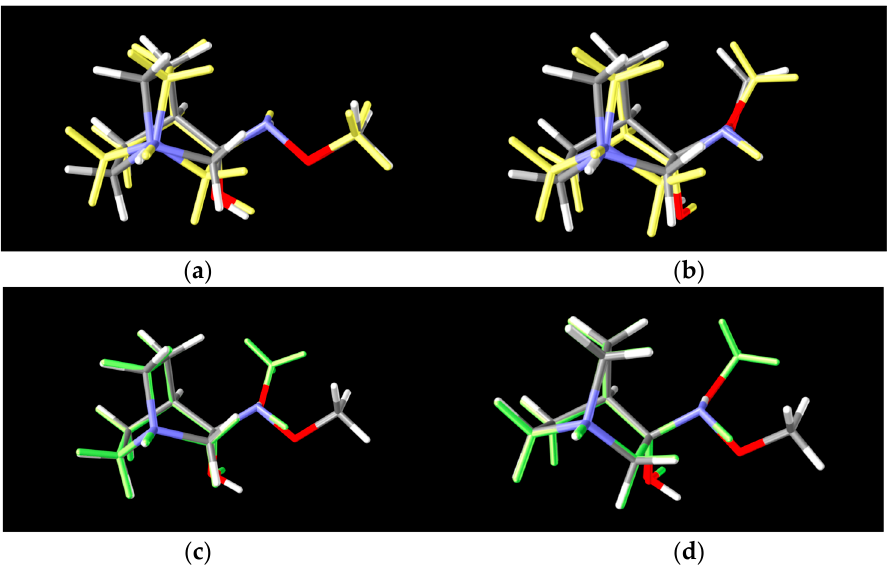
Figure 8. Lowest energy conformers of two polytopes of RI - 1 : ( a ) 2 conformers of the 1st-polytope that differ in bicyclic configuration of the quinuclidine ring ( RI1 - I and RI1 - II ), ( b ) 2 conformers of the 2nd-polytope that differ in bicyclic configuration of the quinuclidine ring ( RI1 - III and RI1 - IV ) (grey: lower energy conformer, yellow: higher energy conformer), ( c ) 2 lower energy polytopes that differ in spatial arrangements of the amino group ( RI1 - I and RI1 - III ) and ( d ) 2 higher energy polytopes that differ in spatial arrangements of the amino group ( RI1 - II and RI1 - IV ) (grey: lower energy polytope, green: higher energy polytope).